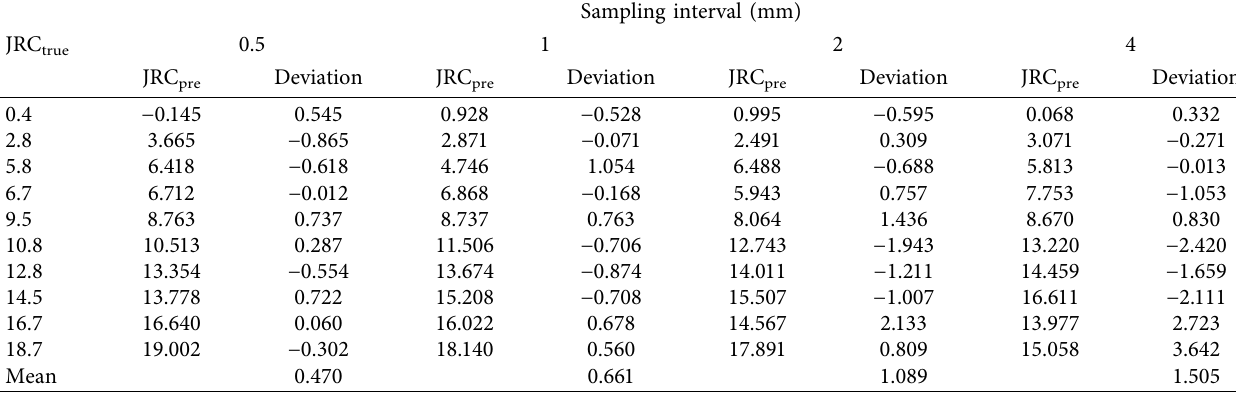
Table 6: Comparison of deviation between JRC pre and JRC true calculated from Sa under different sampling intervals.